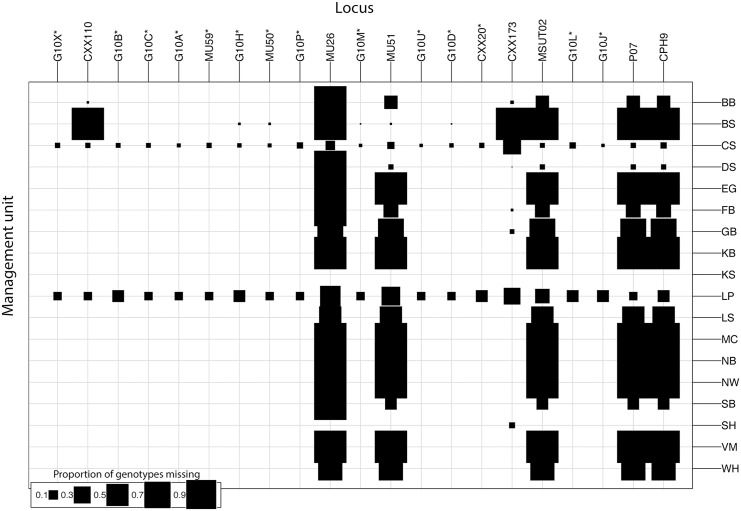
Missing data in Peacock et al., 2015 [20].The size of the square at each management unit–locus intersection is proportional to the amount of missing data at that locus in that management unit. Management unit abbreviations are as in Table 1. Asterisks denote loci that were retained for the reanalysis presented in this paper.